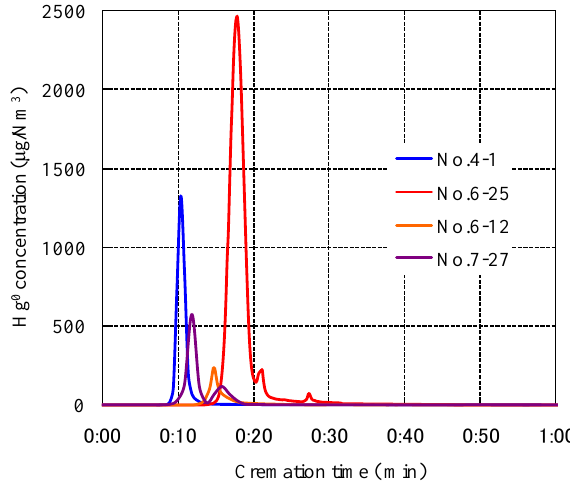
Fig. 3. Temporal changes in the elemental mercury (Hg 0 ) concen- tration in crematory flue Figure 3. Temporal changes in the elemental mercury (Hg 0 ) concentration in crematory flue gas.